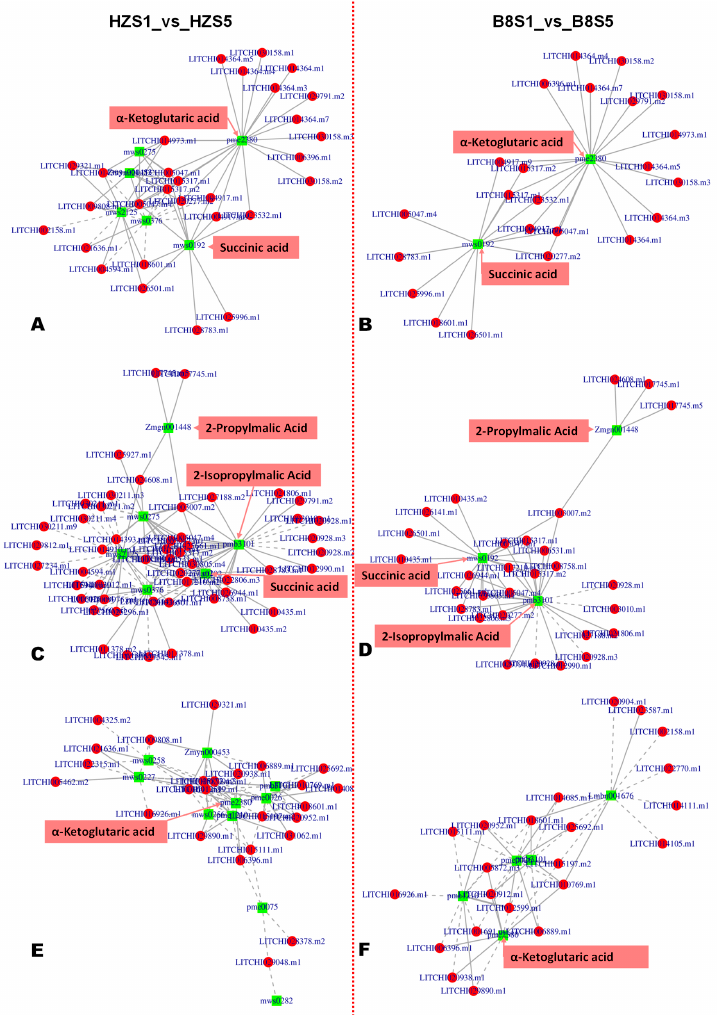
Figure 6. Metabolite–gene networks analysis results of key enriched KEGG pathways of organic acid metabolism. ( A , B ) TCA cycle between HZS1 and HZS5; and between B8S1 and B8S5, respectively. ( C , D ) Pyruvate metabolism between HZS1 and HZS5; and between B8S1 and B8S5, respectively. ( E , F ) 2-oxoglutarate metabolism between HZS1 and HZS5; and between B8S1 and B8S5,